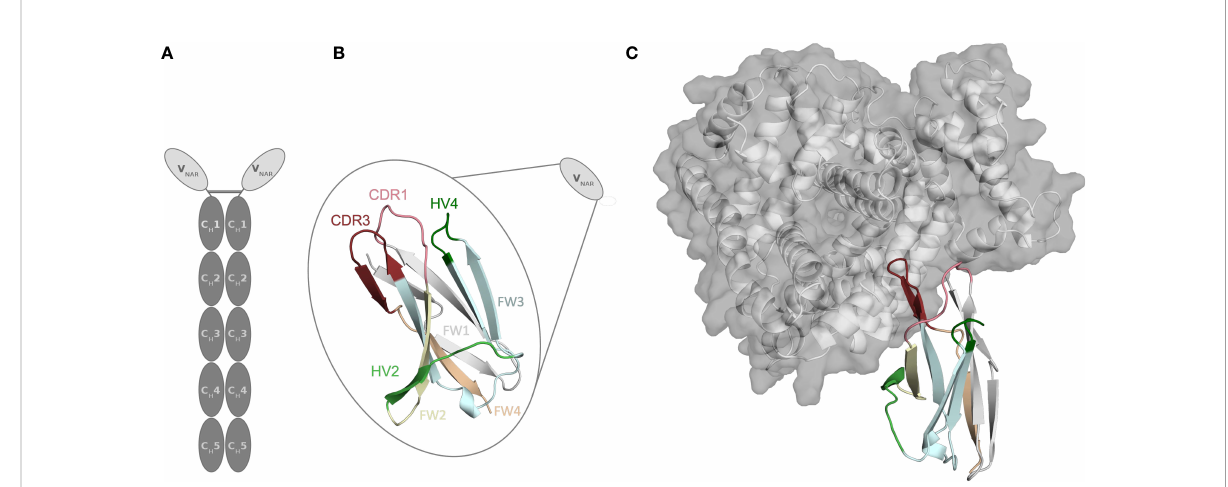
FIGURE 1 Structure of the parent E06 VNAR (PDB: 4HGK) with and without the antigen present. (A) Schematic representation of a new antigen receptor (IgNAR). The fi ve constant domain dimers are shown in dark grey, while the variable single-domains (VNARs) are depicted in light grey. (B) Schematic and structural representation of the parent VNAR E06. The CDR1, and CDR3 loops are colored in pink and red, respectively. The FW1, FW2, FW3, and FW4 are illustrated in light grey, pale green, aquamarine, and pare orange, respectively. (C) Structure of the parent E06 VNAR in complex with the antigen